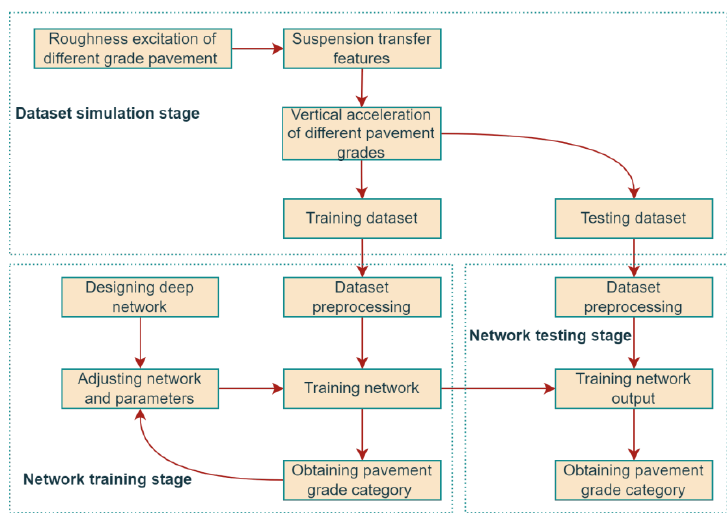
Figure 4. Recognition algorithm flow for the pavement roughness category .